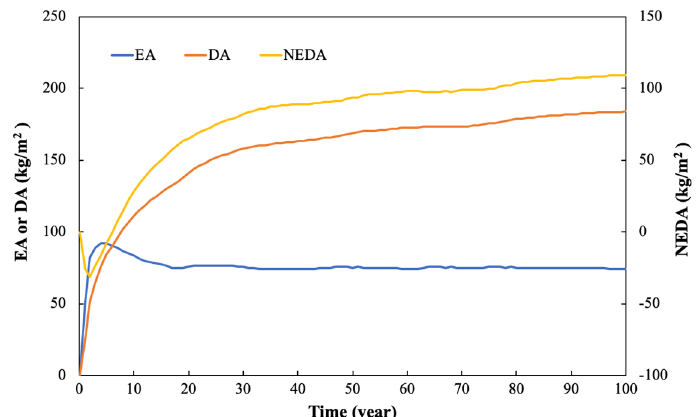
Figure 4. Erosion amount (EA), deposition amount (DA), and net erosion or deposition amount (NEDA) per unit area of the ideal model of Qilihai Lagoon system of the control group.